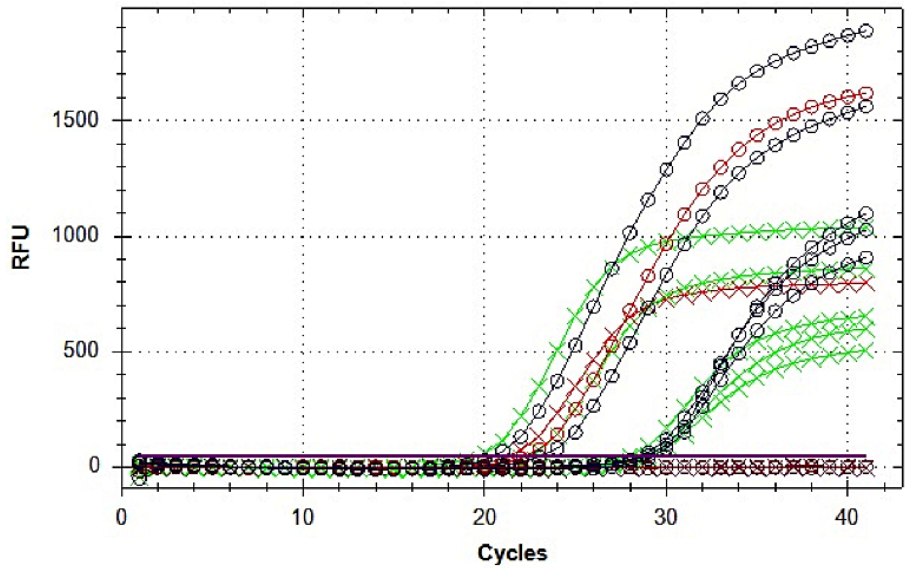
Figure 1. Duplex TaqMan real-time RT-PCR amplification plots for the detection of ToBRFV in five individual tomato plants. Black and green curves show amplification from symptomatic tomato samples. Red curves, positive (total nucleic acid extracted from infected tomato tissues) controls. Brown curves, negative (no template nucleic acid) controls. Black circle (O) and green cross (X) symbols indicate amplification curves with primer/probes CaTa28/FAM and CSP1325/ Cy5,